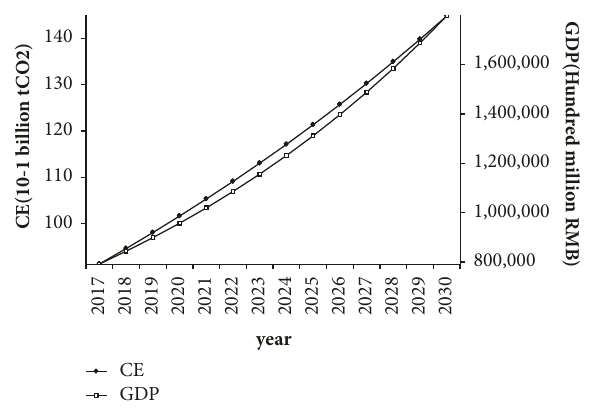
Figure 6: The trends of carbon emissions for energy consumption and GDP (2017-2030). Table 7: The values of carbon intensityand energyintensity in 2005, 2015, 2020, and 2030. Carbon intensity Energy intensity (kgCO2/yuan) (kgce/yuan) 2005 2.130